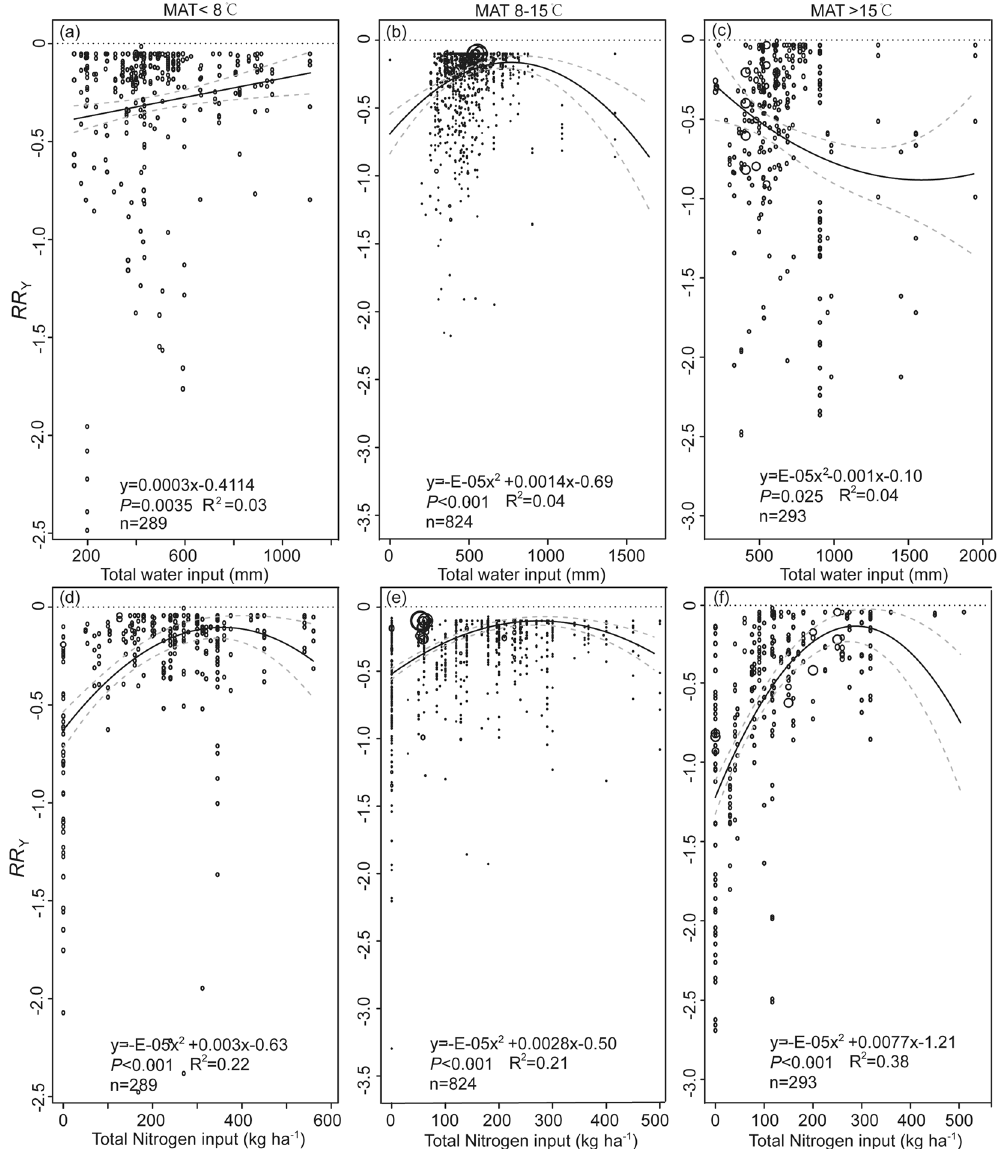
Figure 4. Scatter plot of response ratio of yield ( RR Y ) to water input when mean annual temperature (MAT) is ( a ) < 8 °C, ( b ) 8–15 °C, or ( c ) > 15 °C; to nitrogen input when MAT is ( d ) < 8 °C, ( e ) 8–15 °C, or ( f ) > 15 °C. Response ratio stands for effect size between the treatment and control and is calculated using Eq. 2. The solid black line represents the weighted regression line based on variance-weighted least squares. The grey line shows the 95% CI around the regression line. The circles indicate the response ratio of each observation. The circle size is proportional to the precision of the response ratio. Note the different scales among the